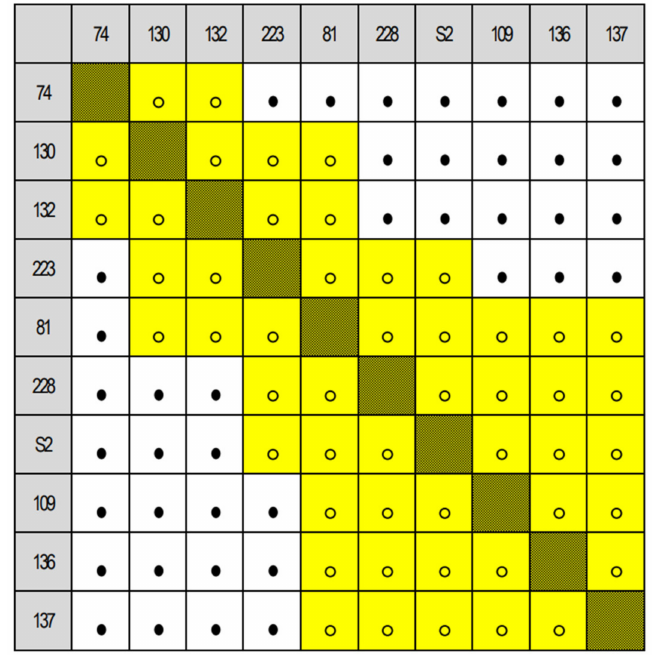
Figure A4. Matrix of significance of population mean height differences of the trial P í sek, sorted by the group average of mean heights (best in top